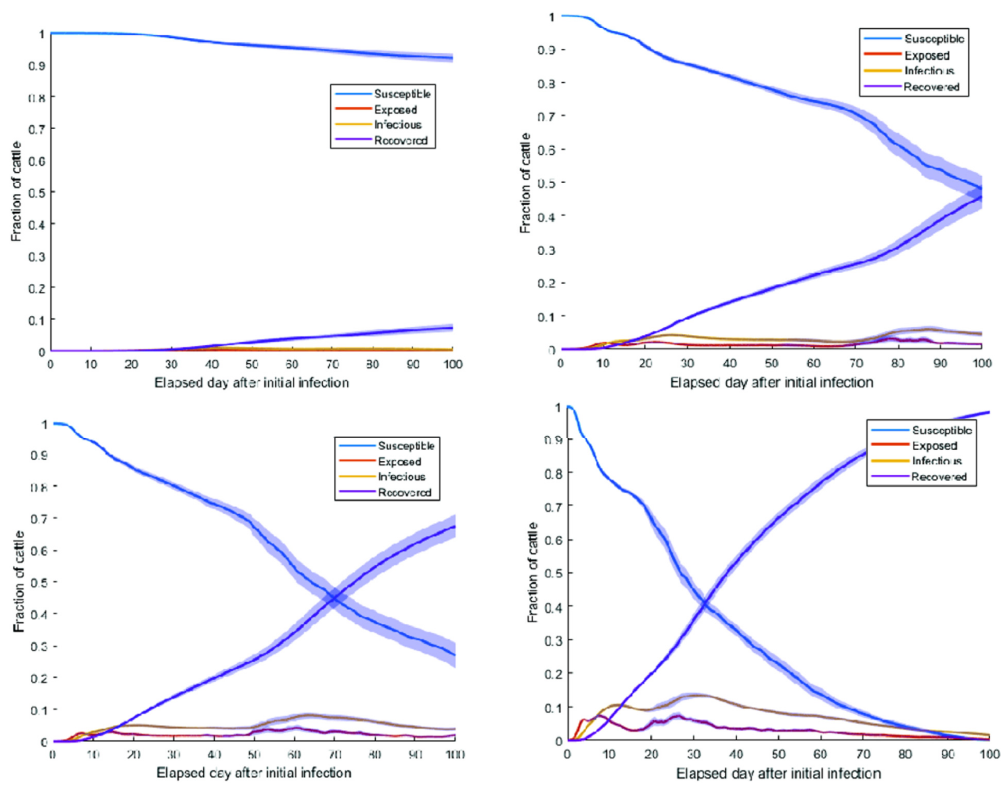
Fig 10. Fraction of cows in each compartment with a 95 percent confidence interval for β = 0.001 (top left), 0.005 (top right), 0.01 (bottom left), and 0.03 (bottom right) and for a homogeneous network; increasing β showed an increasing trend in the overall fractions of infected (cumulative fractions of